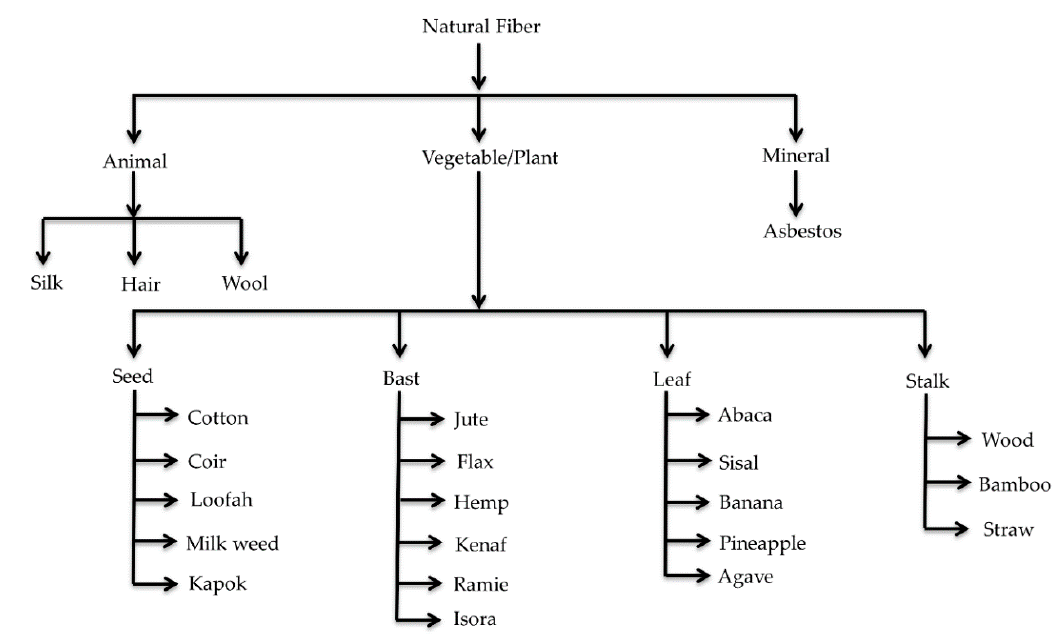
Figure 1. Natural fiber classification, according to the origin, with examples. Adapted with permission from Elsevier [9]. Copyright Elsevier, 2019.